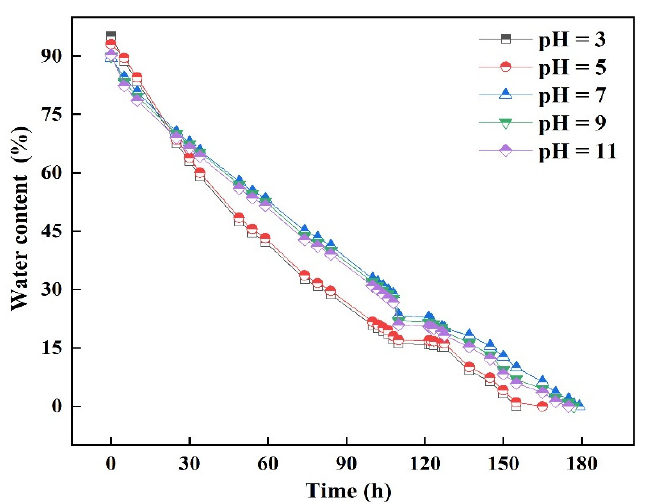
Figure 8. Water release capacity of water storage materials under different pH conditions .